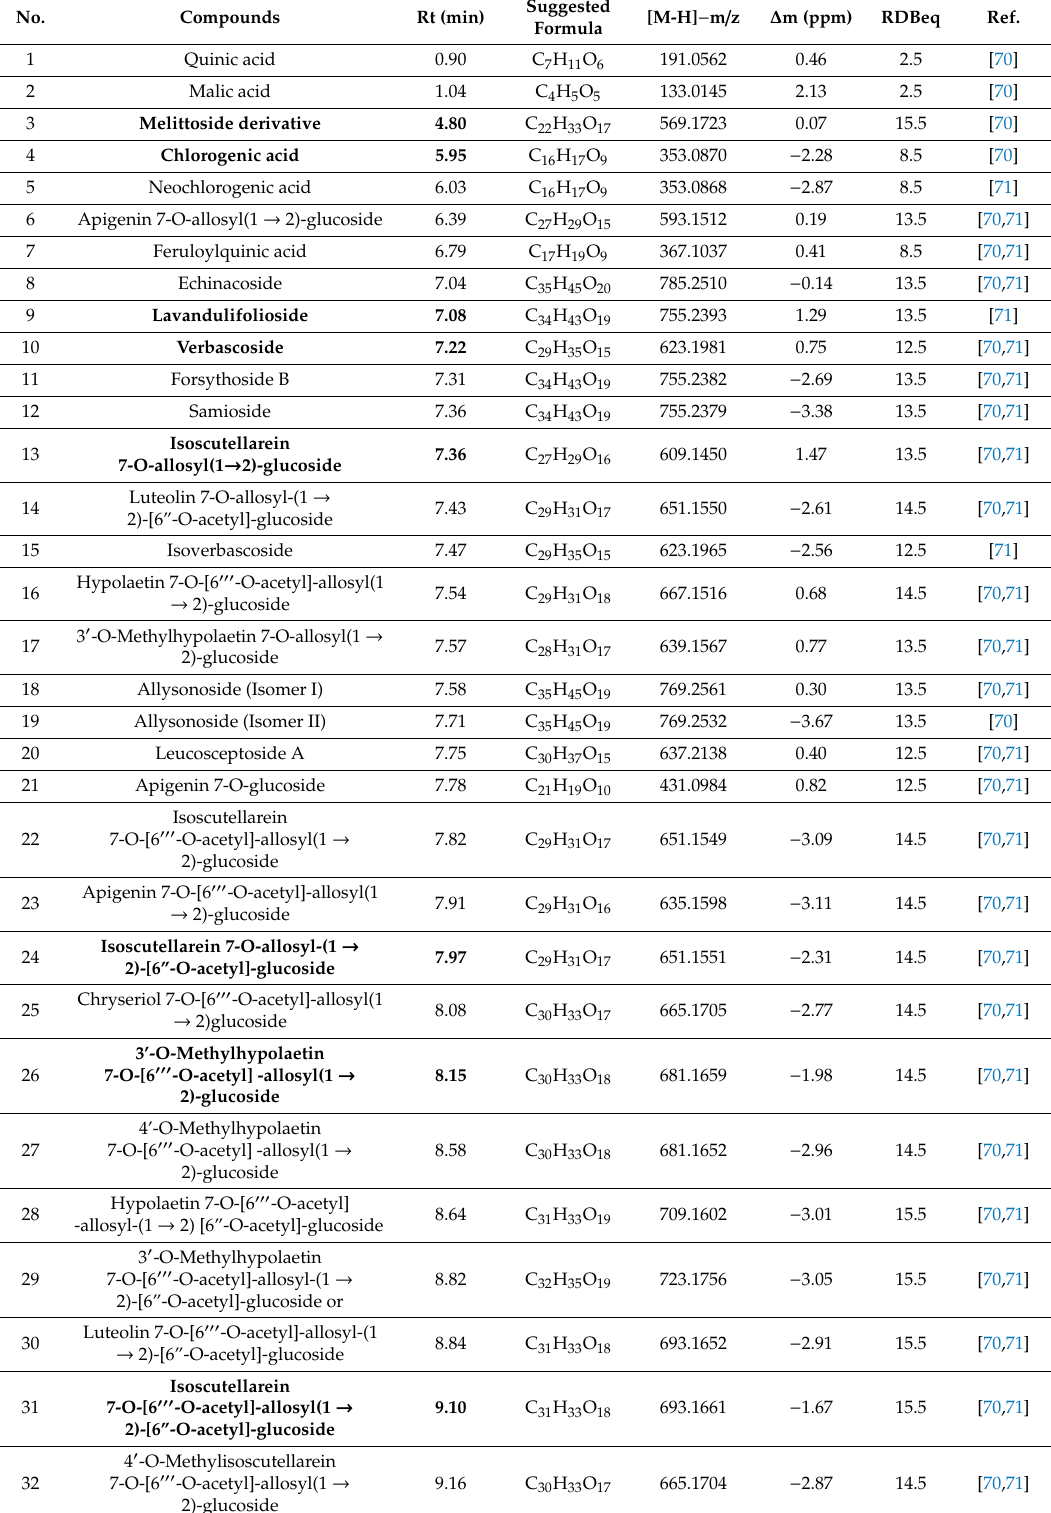
Table A2. Secondary metabolites identified in the S. scardica water / ethanol extract by UPLC-ESI(-)-HRMS / MS (with bold the major peaks of total ion chromatogram). Suggested